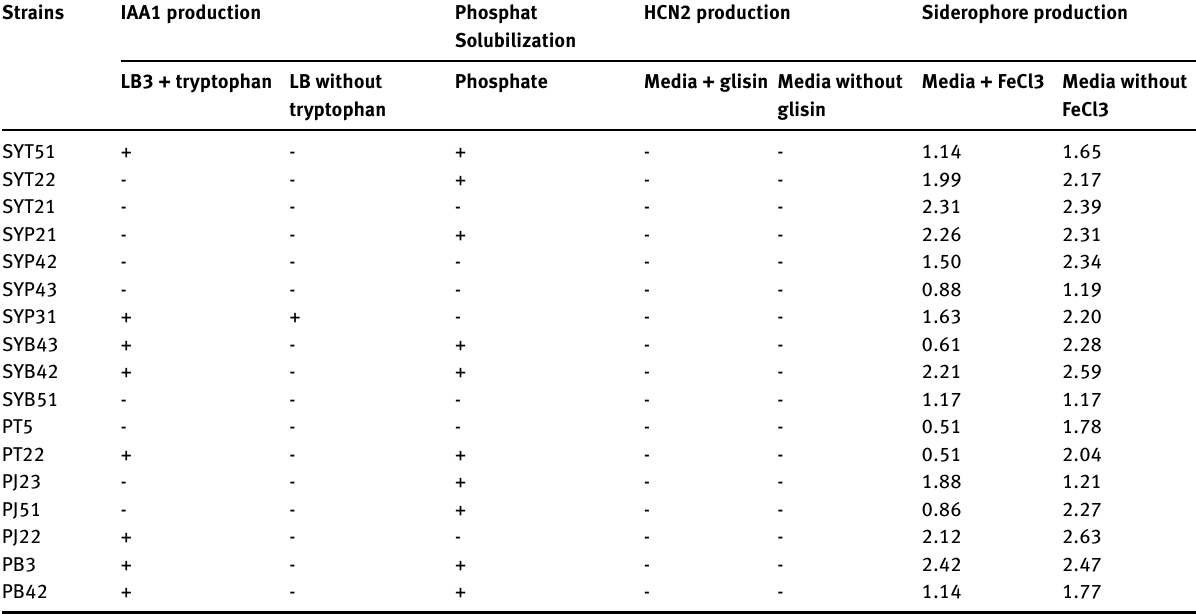
Table 4: Production of indole acetate acid (IAA), HCN, siderophore and phosphate solubilization of rhizospheric bacterial strains Strains IAA1 production